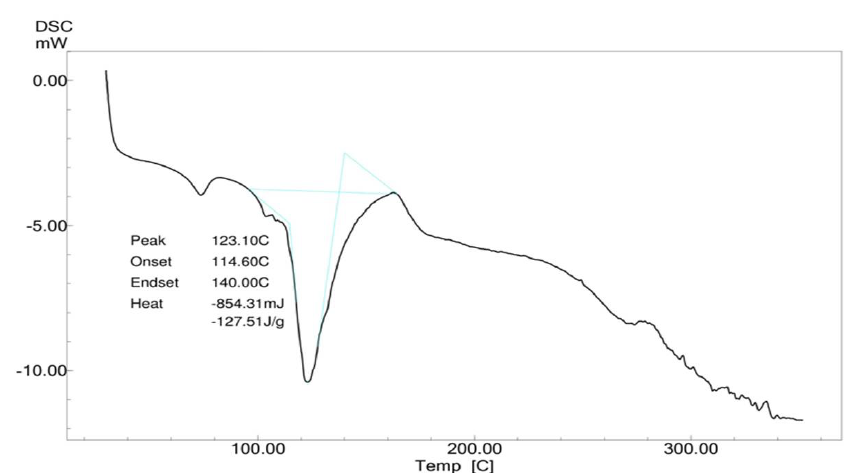
Figure 7. DSC of Calendula officinalis oil.